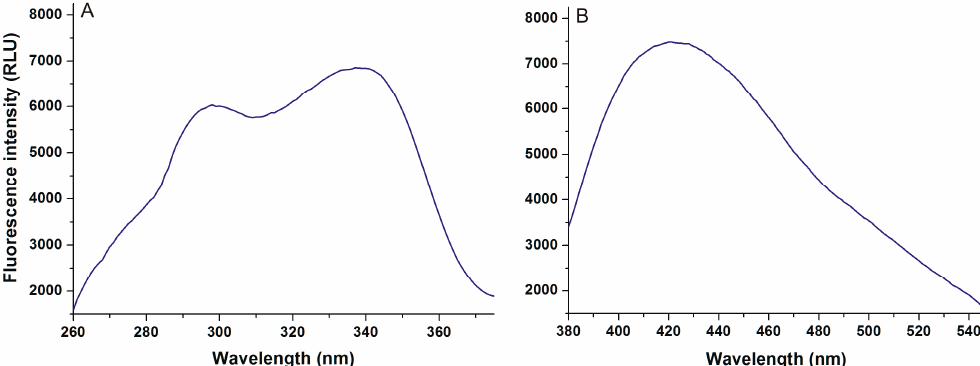
Figure 2. Fluorescence excitation ( A ) and emission ( B ) spectra of 50 μ M alternariol (AOH) in phosphate buffered saline (PBS) (pH 7.4; λ ex = 345 nm, λ em = 421 nm).